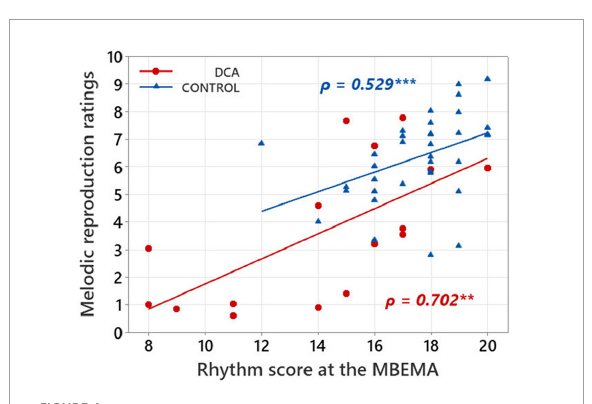
FIGURE4 Scatterplot illustrating the correlations between mean ratings in melody singing and scores on the MBEMA Rhythm subtest. Regression lines are fitted for each group and the Spearman’s ρ are indicated. ∗∗ p < 0.01 and ∗∗∗ p <